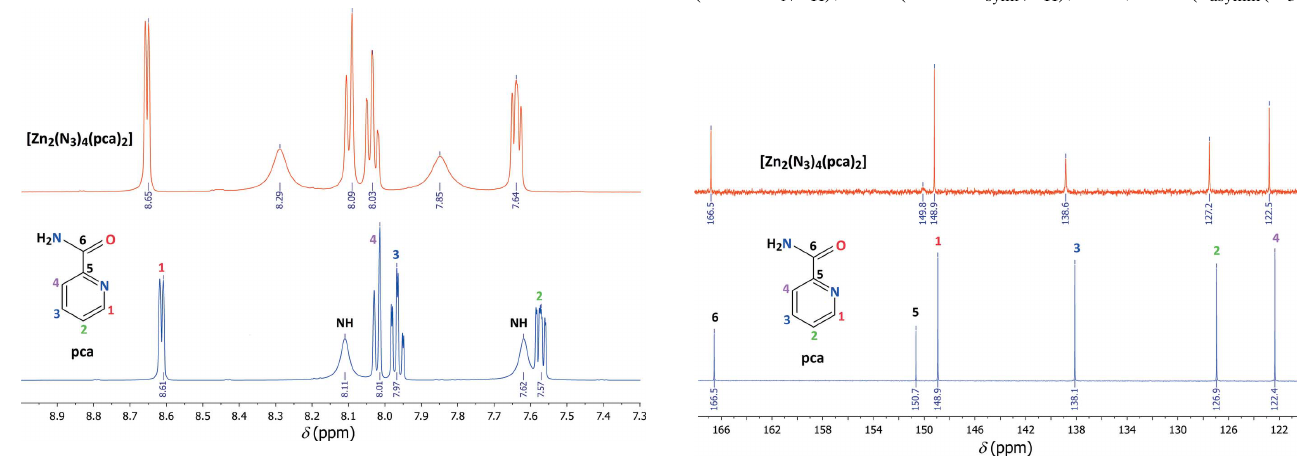
Figure 4 Experimental 1 H-NMR spectra of pca (blue) and [Zn 2 (N 3 ) 4 (pca) 2 ] (red) in DMSO- d 6 . Chemical shifts and coupling constants are given in Table